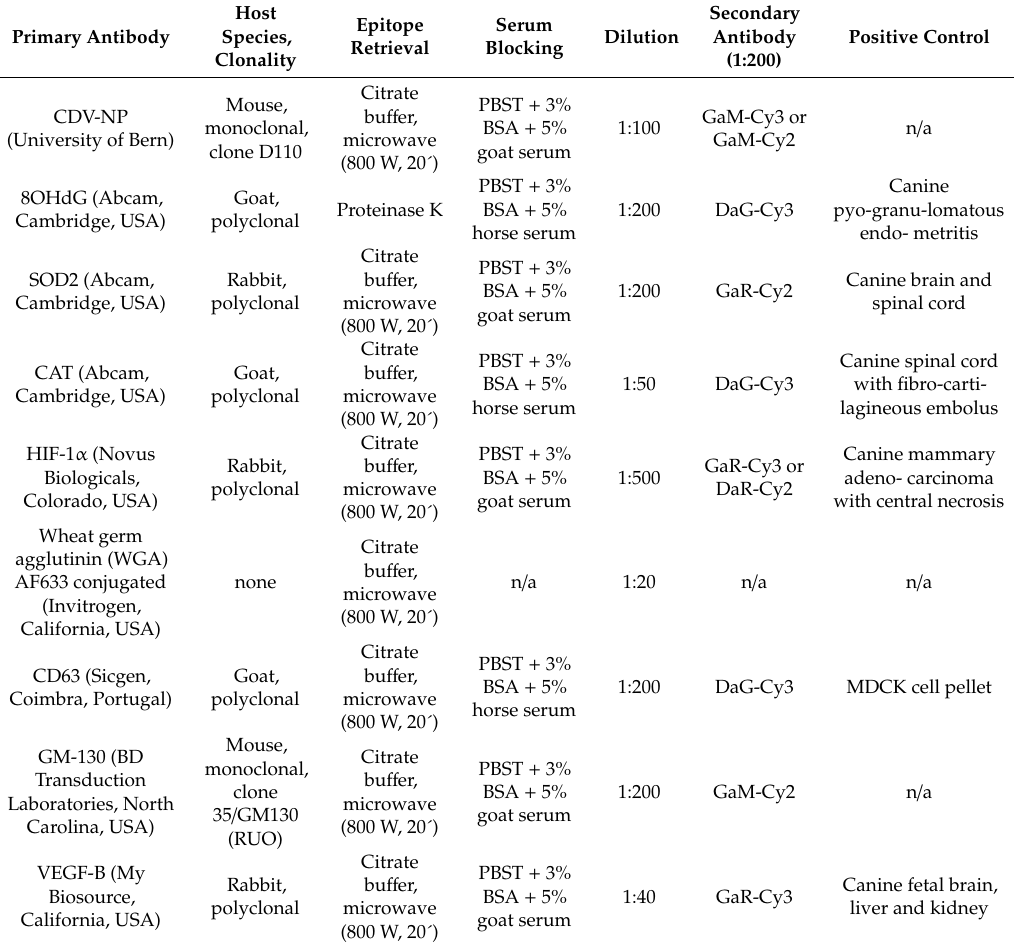
Table 1. Details of the antibodies used for the immunostaining performed, including primary antibody, hostspecies, clonality, epitoperetrievalmethod, blockingserum, dilutionofprimaryantibody, secondary antibody and positive